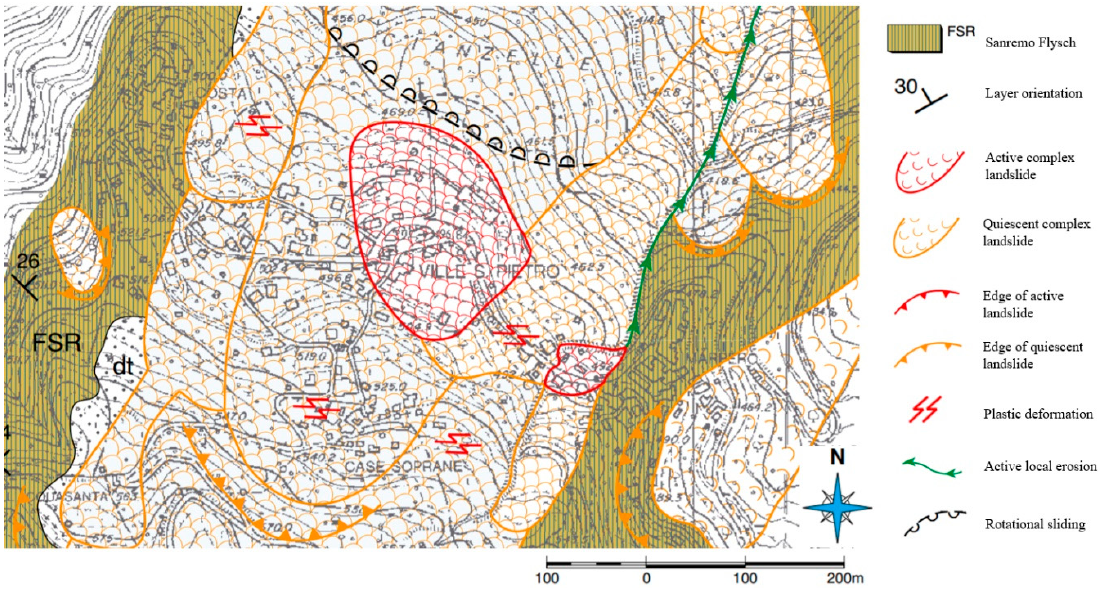
Figure 2. Geomorphology map of Ville San Pietro (adapted from [21]).